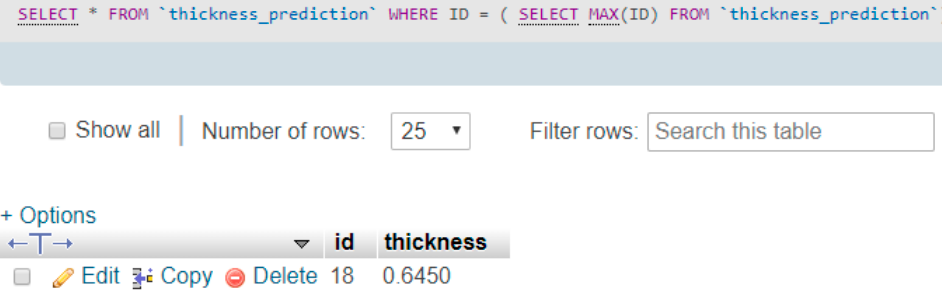
Figure 16. Querying the MySQL database for the latest input.